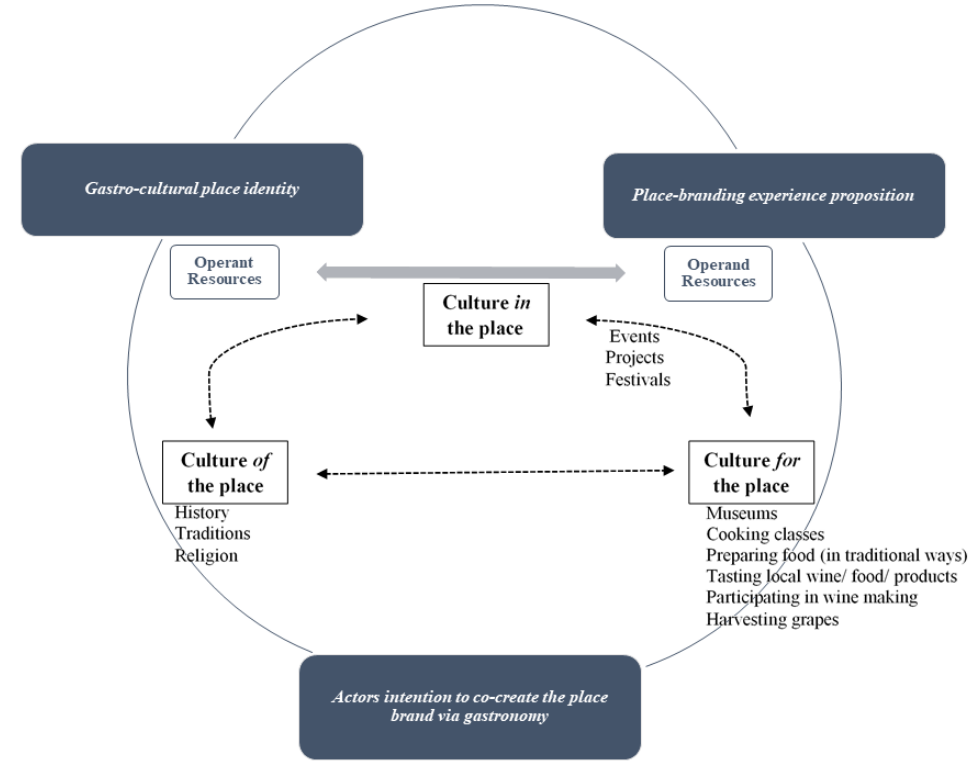
Figure 2. The gastro-cultural identity & experience proposition framework.